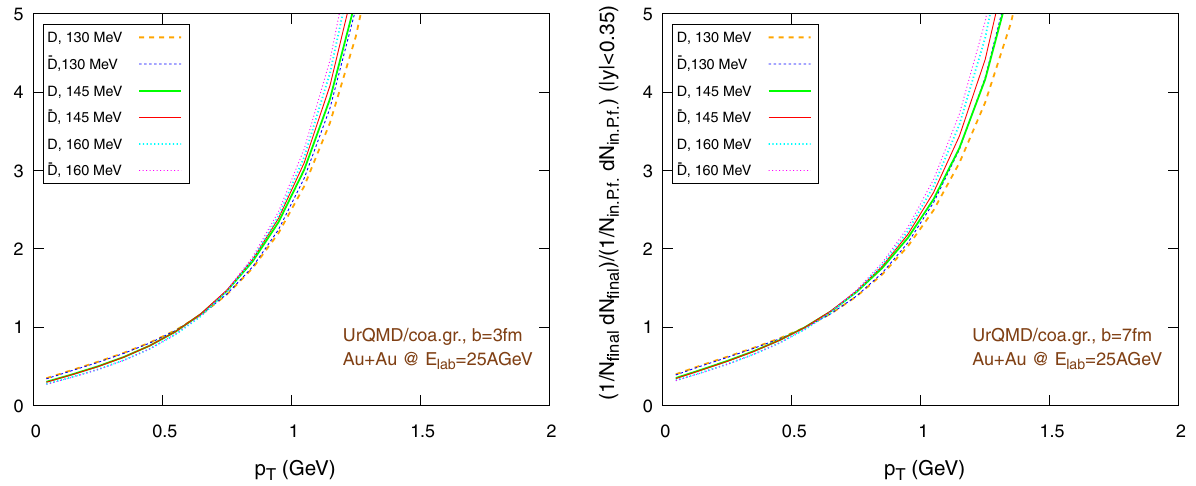
= 25AGeV, using the | y | < 0 . 35, for Au+Au collisions at E lab UrQMD/coarse-graining approach. The hadronization parameters are (cid:13) (cid:14) (cid:23) = 0 . 05 and = 0 . 6fm. Left: b = 3fm, right: b = 7fm r D p rms